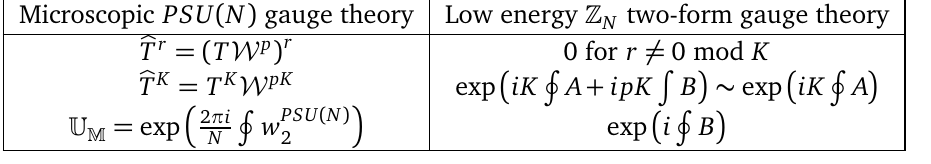
Table 5: The dictionary between the operators in the microscopic PSU ( N ) gauge theory and the operators in the macroscopic (cid:90) two-form gauge theory. The line N operator in the second row is the minimal line that obeys a perimeter law. It is identified with the genuine line operator in the low-energy theory (and hence we suppress the B dependent term). Here we use a continuous notation for the low- energy TQFT, which is reviewed in appendix E. Microscopic PSU ( N ) gauge theory Low energy (cid:90) two-form gauge theory N r = ( T p ) r 0 for r (cid:54) = 0 mod (cid:98) T W